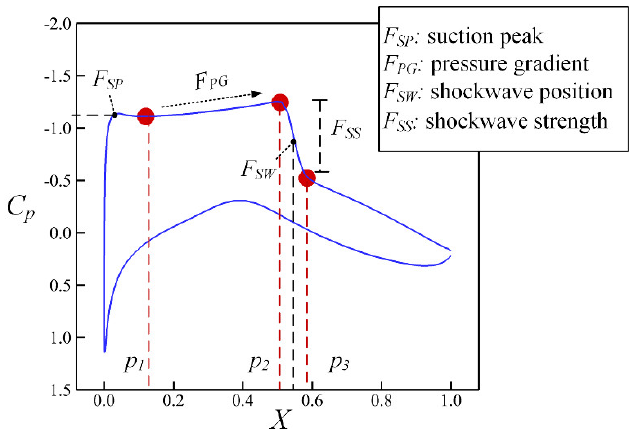
Figure 5. Features of C p distribution.